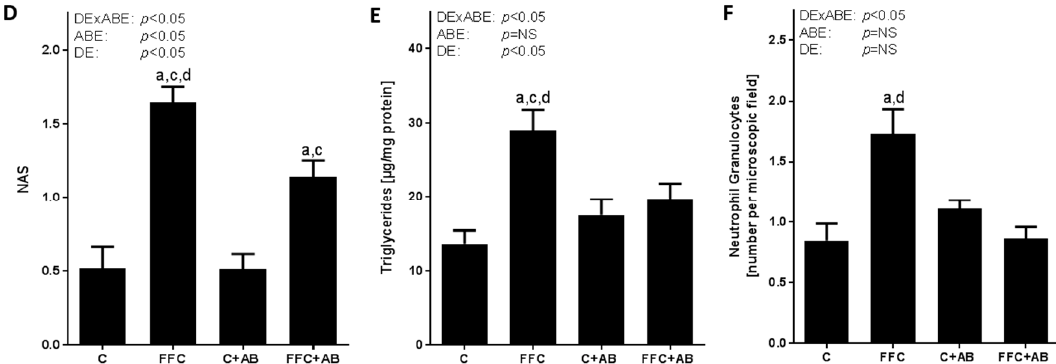
Figure 2. Effect of the short-term feeding of a FFC or control diet ± oral antibiotic treatment on liver. Representative pictures of ( A ) heamatoxylin and eosin staining (200 × ); ( B ) Oil Red O staining (200 × ) and ( C ) neutrophilic granulocytes (200 × ; arrows are indicators for neutrophilic granulocytes; FFC section 630 × ) of liver sections; ( D ) Evaluation of liver damage using NAS and ( E ) quantification of hepatic triglyceride accumulation; ( F ) Number of neutrophilic granulocytes in liver. ABE: antibiotic effect; C: control diet; C + AB: control diet and oral treatment with antibiotics; DE: diet effect; DE × ABE: interaction between diet and antibiotics; FFC: fat-, fructose- and cholesterol-rich diet; FFC + AB: fat-, fructose- and cholesterol-rich diet and oral treatment with antibiotics; NAS: NAFLD activity score; NS: not significant. a p < 0.05 compared with mice fed a control diet; c p < 0.05 compared with